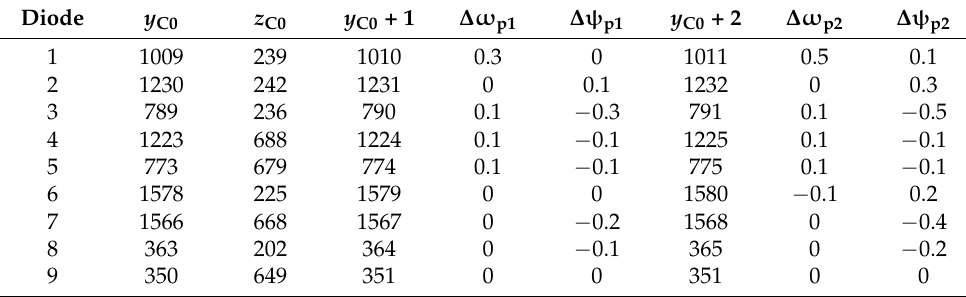
Table 5. Changes of measured angles when changing pixel